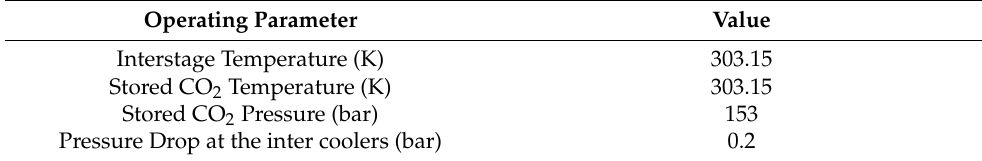
Table 3. Underground storage process assumptions.